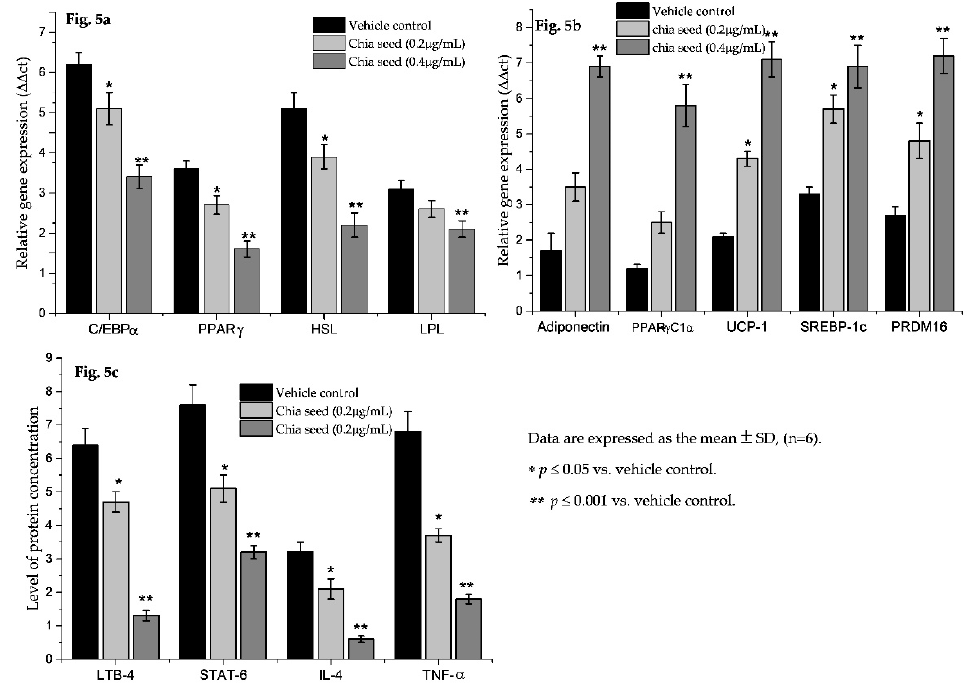
Figure 5. Effect of chia seed fatty acid extract on adipogenesis ( a ), adipocyte mitochondrial thermogenesis ( b ) related mRNA expression levels and protein levels ( c ) in adipocytes.